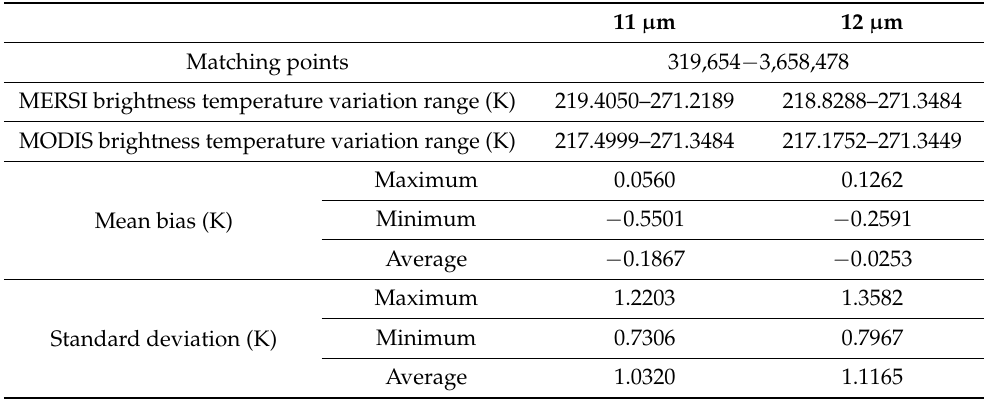
Table 5. Statistical values of T b data between channels 11 µ m and 12 µ m of MERSI and MODIS from